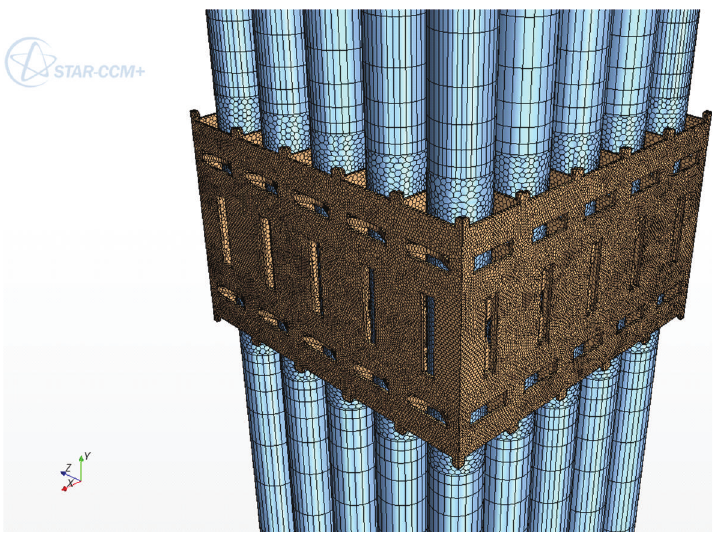
Figure 2: CFD grid of spacer without mixing